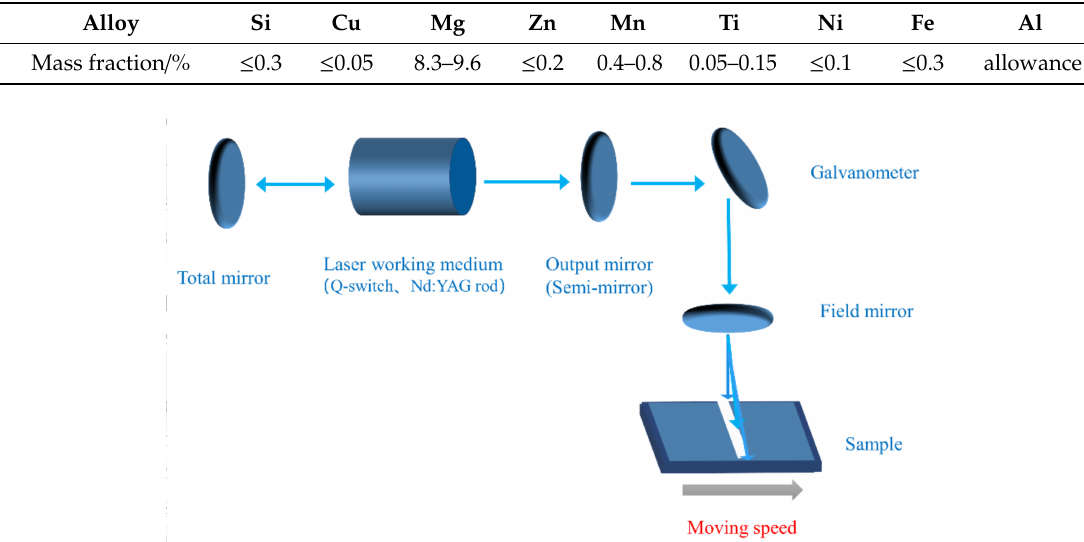
Table 1. Chemical composition of the aluminum alloys 5A12.